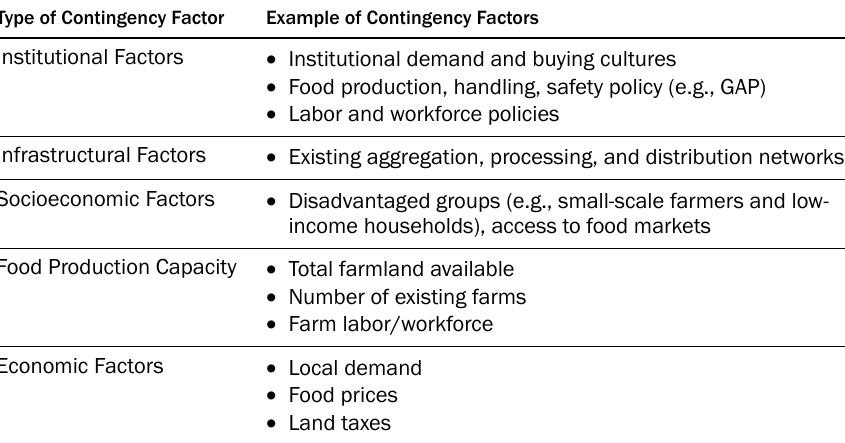
Table 5. Contextual Factors Stakeholders Should Consider When Developing Local Food